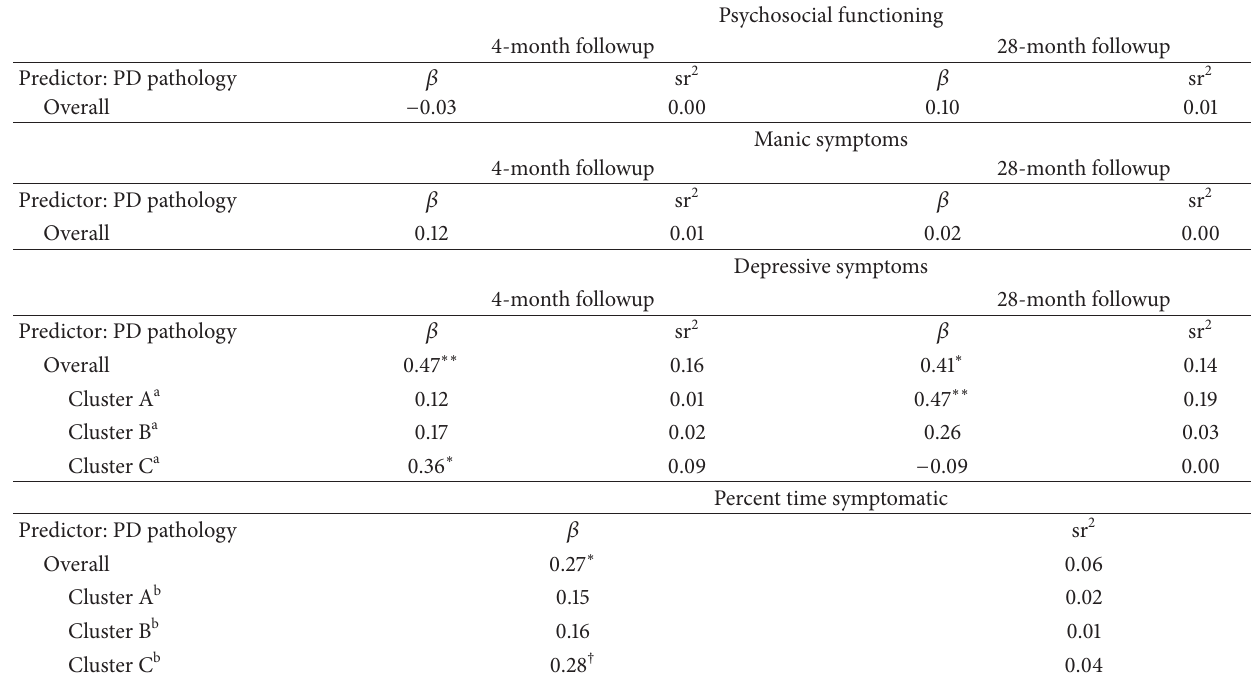
Table 2: Hierarchical multiple regression analyses predicting psychosocial functioning, manic and depressive symptoms, and percent time symptomatic from personality